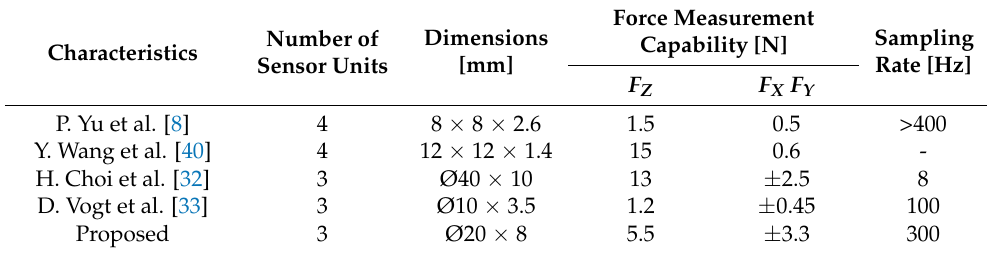
Figure 6. ( a – c ) Results of the calibrated forces in X-, Y-, and Z-axis, respectively, with RMSE. Blue solid lines indicate reference force, and red dashed lines indicate calibrated force. ( d ) Force error in three-axis, which is smaller than 50 mN in all three axes. Table 2. Comparison of force measurement capacity of three-axis force tactile